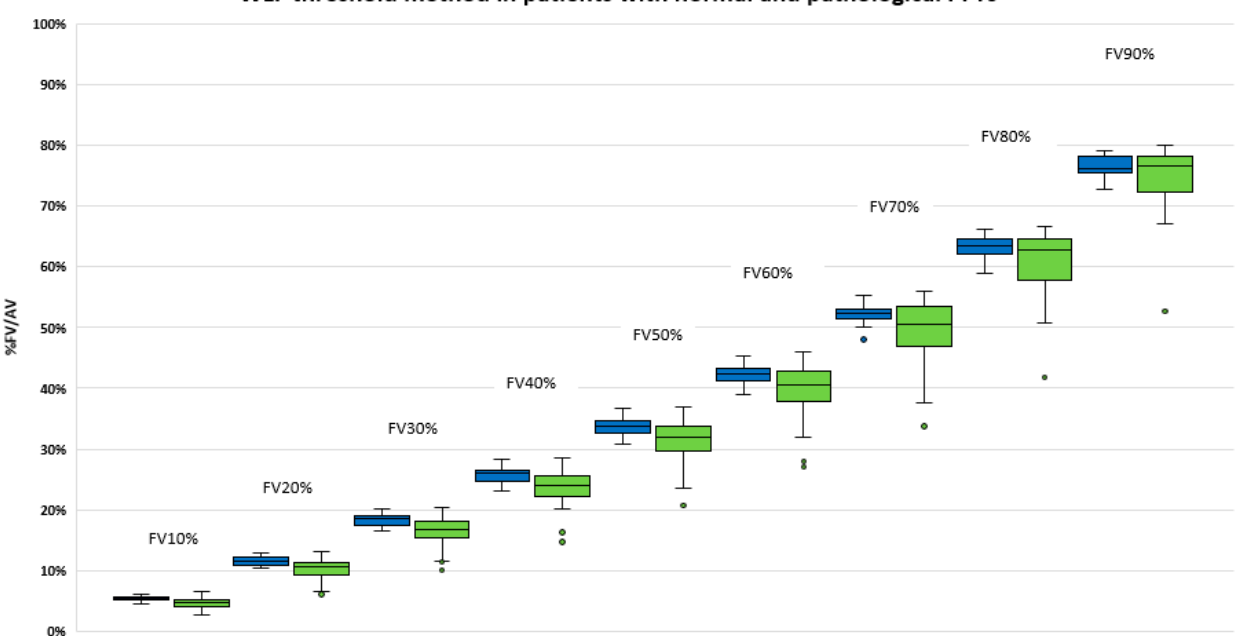
Figure 4. Functional volumes (% AV volume) using WLF threshold method in patient with normal PFT (left, blue) and with pre-existing airway disease (right, green) (FEV1/FVC < 0.7 or DLCO < 60%).